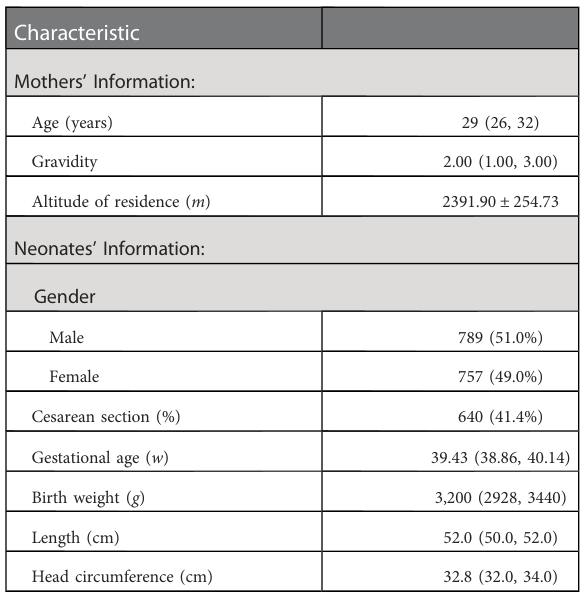
TABLE 1 General characteristics of the study